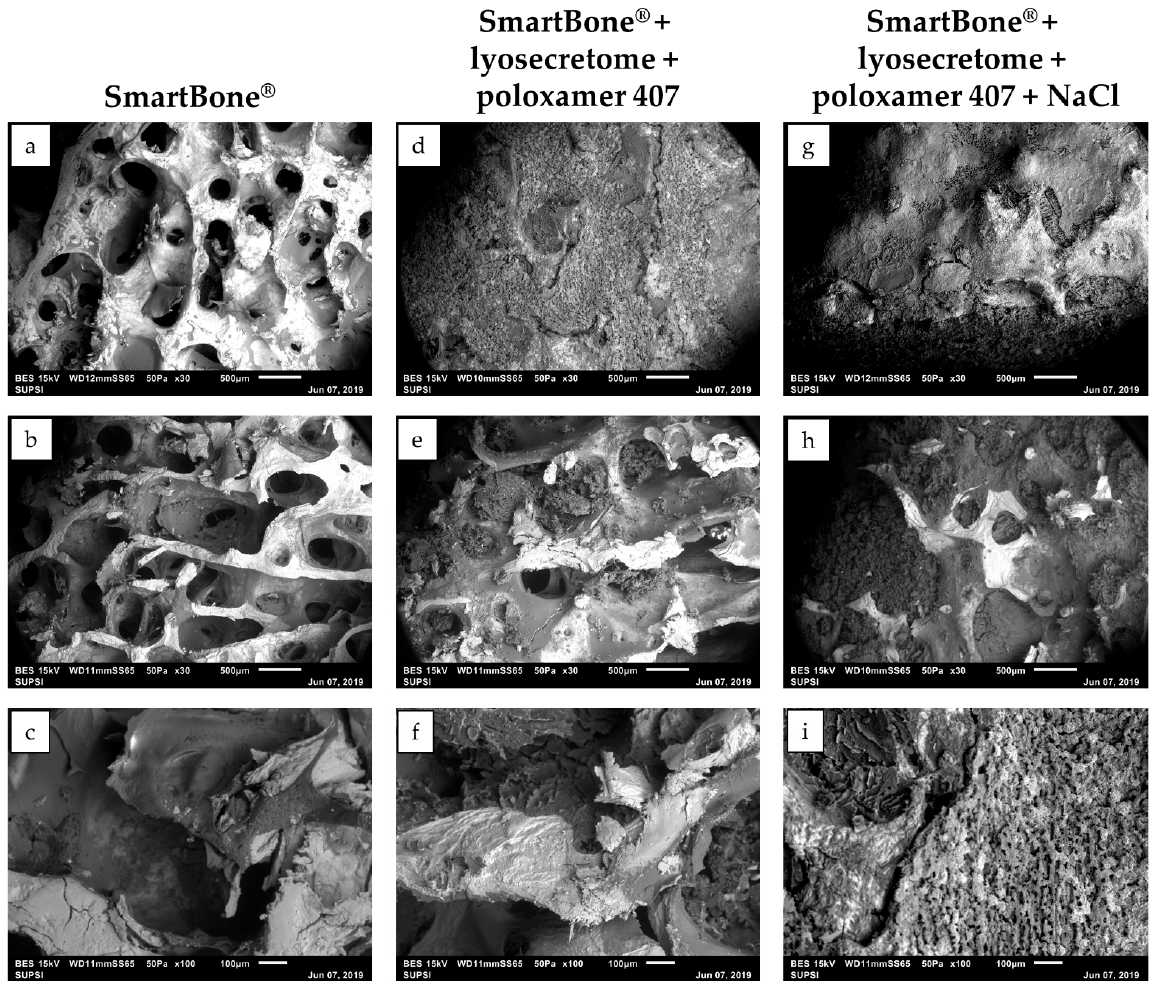
Figure 1. Morphological investigation by ESEM of SmartBone ® ( a – c ) and SmartBone ® + lyosecretome scaffolds with ( d – f ) and without ( g – i ) NaCl before drug release studies. SEM images were taken at increasing magnifications (30× and 100×). Scale bar: 500 and 100 µm.